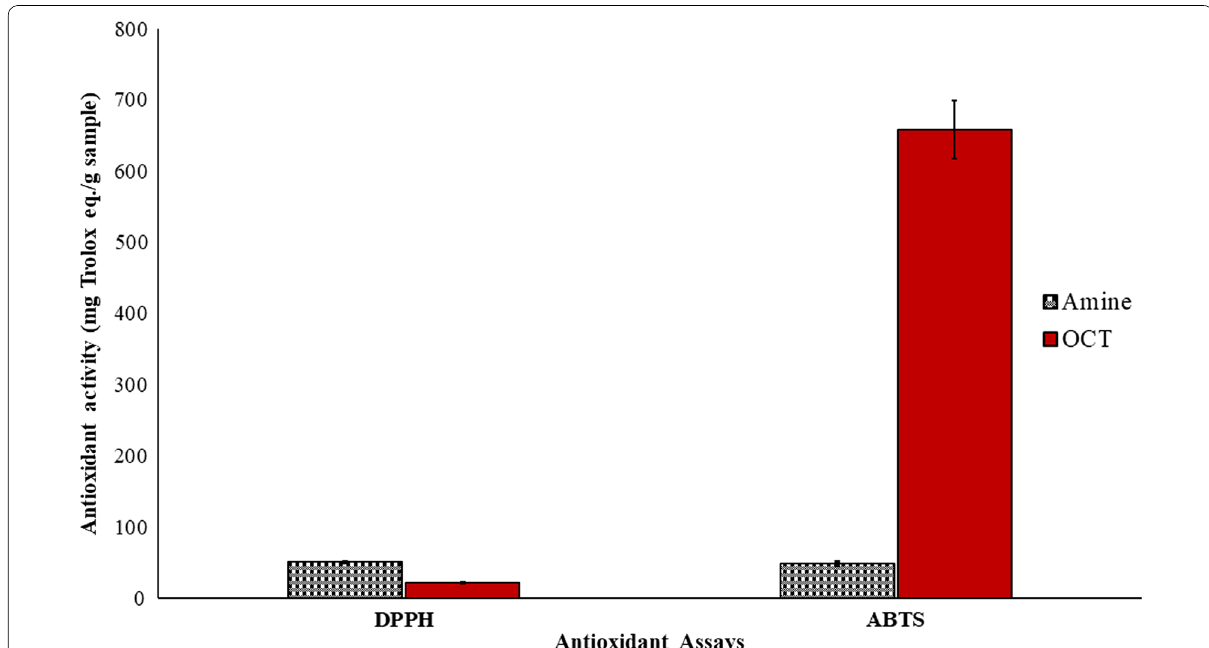
Fig. 14 DPPH · and ABTS ·+ scavenging activity of OCT and AMINE. Results are displayed as mean